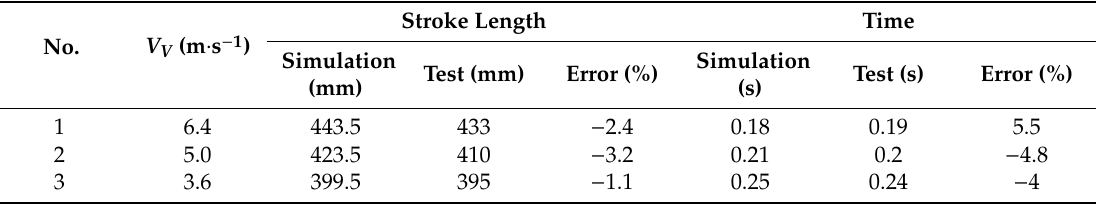
Table 1. Comparison of simulation and test